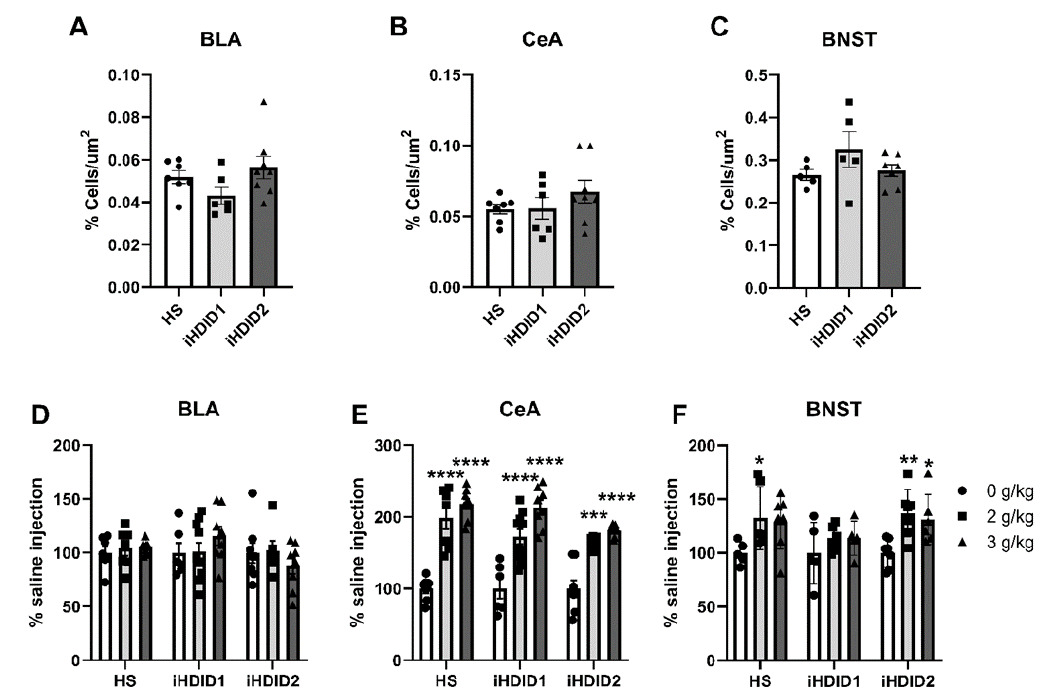
Figure 5. C-Fos Levels in the Extended Amygdala. ( A – C ) No difference in saline-induced c-Fos activation was detected between genotypes in any area. ( D ) Ethanol induced no change in c-Fos levels relative to saline in any genotype in the BLA. ( E ) Ethanol induced robust changes in c-Fos levels relative to saline in any genotype in the CeA. ( F ) Ethanol induced increased c-Fos levels in the BNST in the HS and iHDID2, but not iHDID1 line. * p < 0.05, ** p < 0.01, *** p < 0.001, and **** p < 0.0001 from two-way ANOVA Tukey’s multiple comparisons